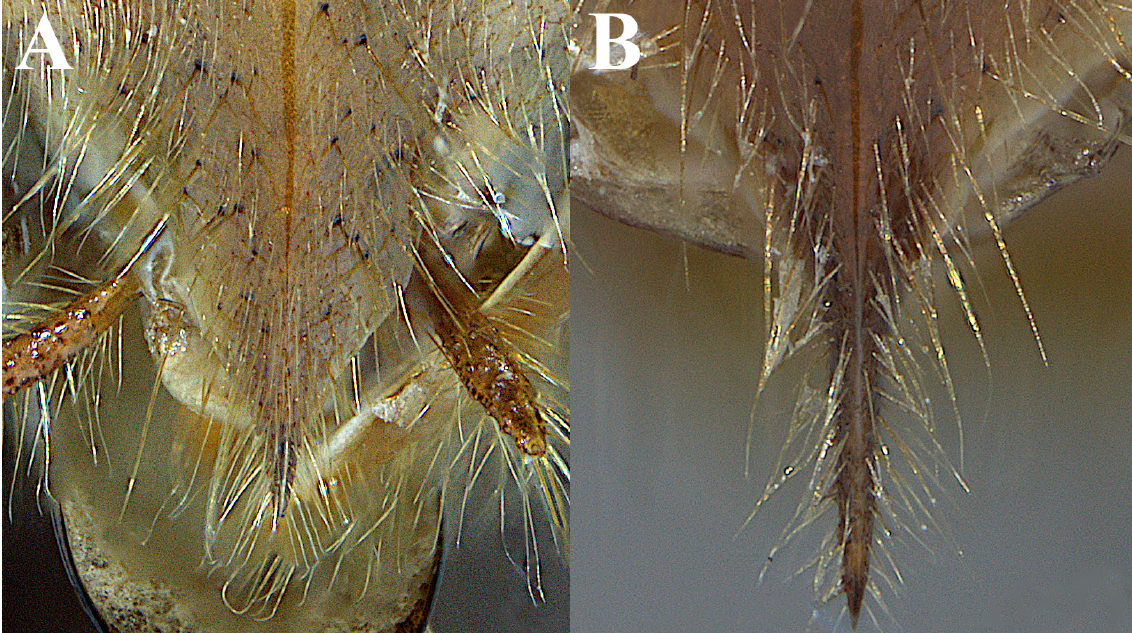
Fig. 12. Detail of abdominal tergite VIII. A . Dinoponera lucida Emery, 1901. B . Dinoponera morphospecies 1. No